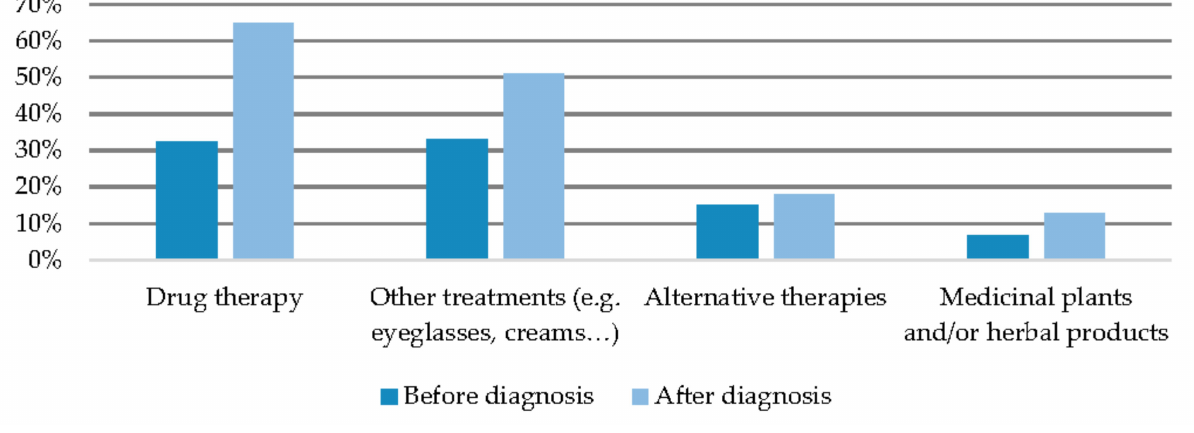
Figure 3. Types of treatment before and after